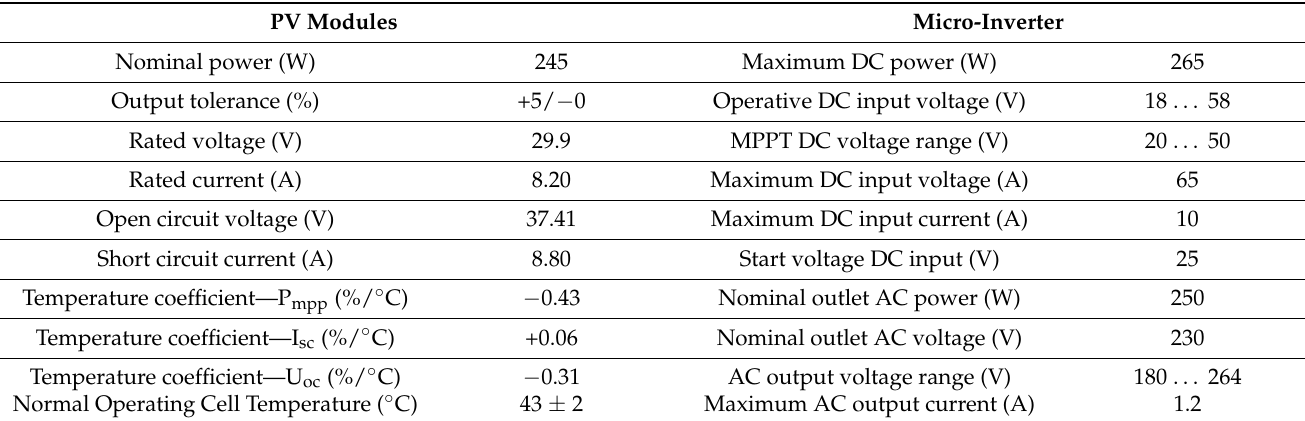
Table 1. Electric characteristics of the photovoltaic systems (PV) modules and Micro-inverter.